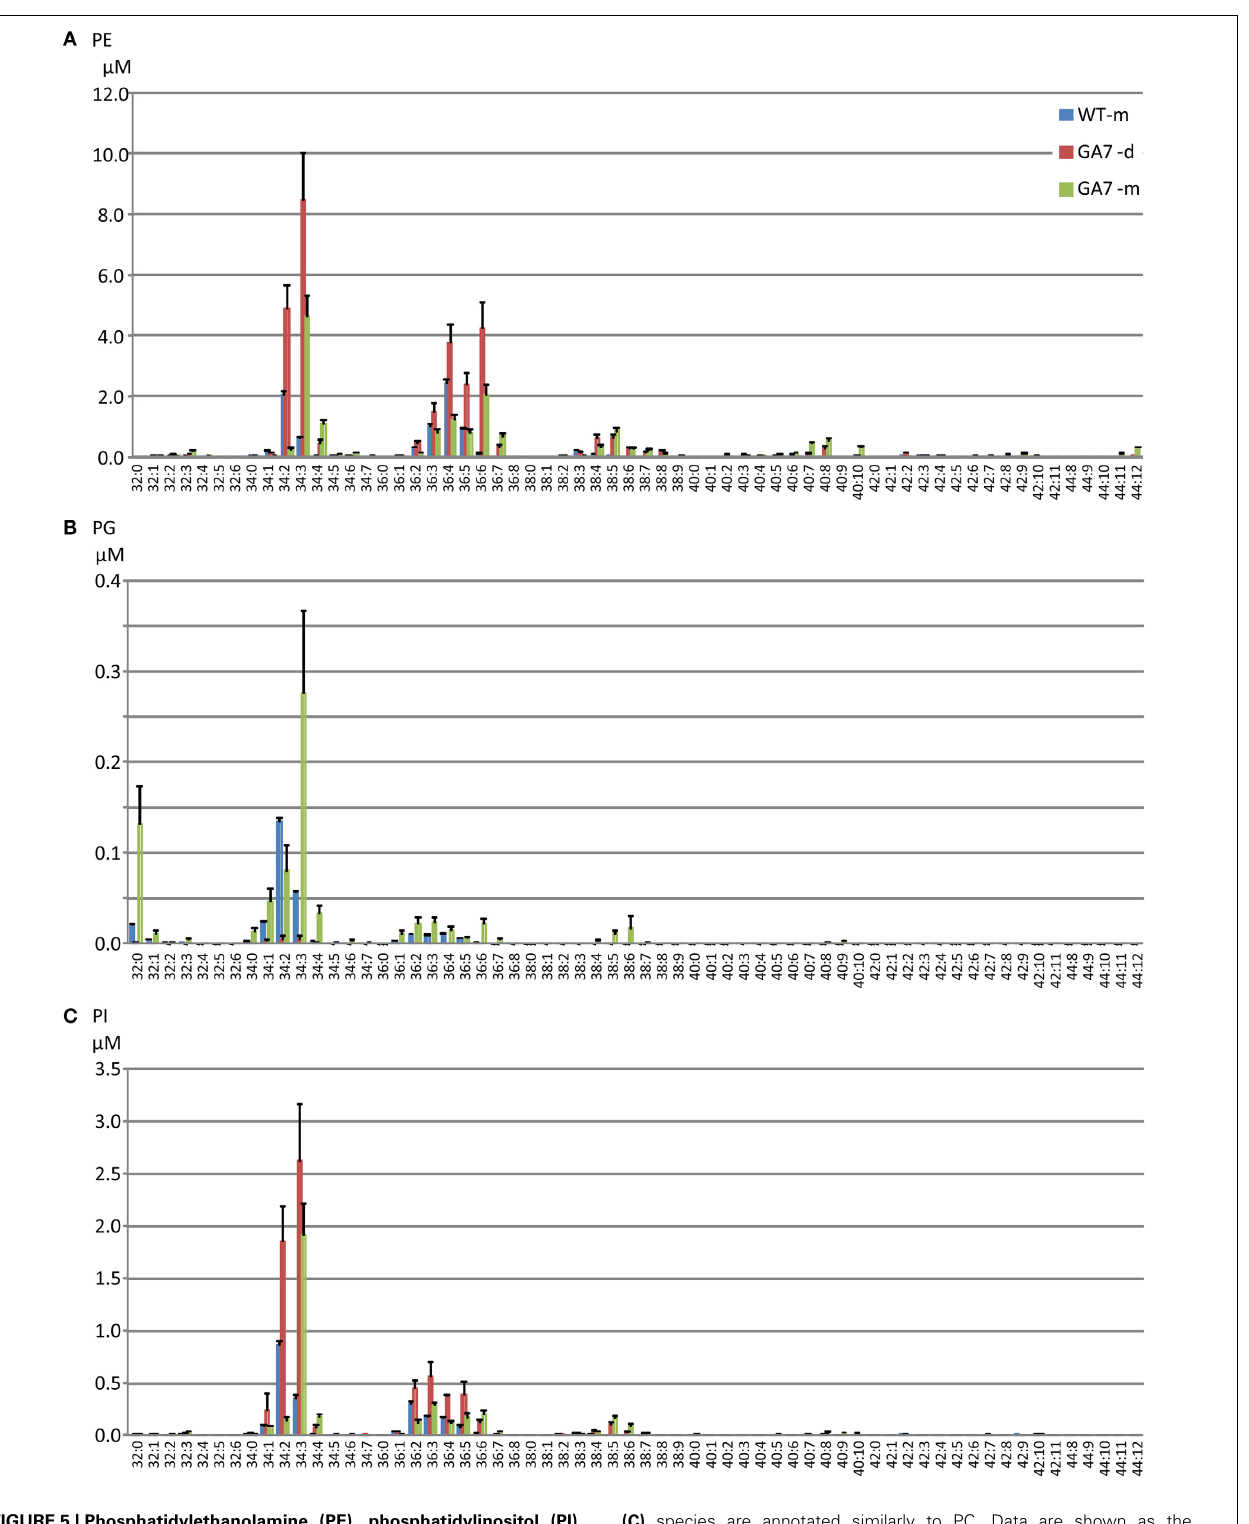
FIGURE 5 | Phosphatidylethanolamine (PE), phosphatidylinositol (PI) and phosphatidylglycerol (PG) pools in the developing and the mature Arabidopsis seeds. The phospholipids PE (A) , PG (B) and PI